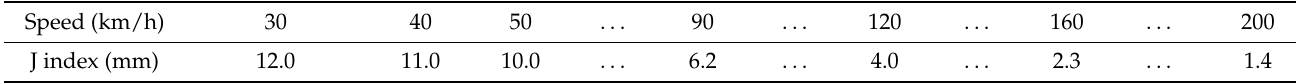
Table 1. Allowable deviations of the J index depending on